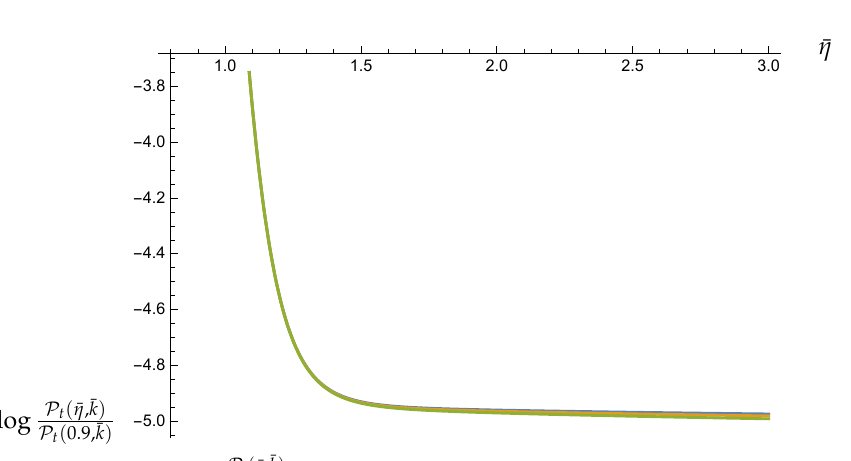
Figure A2. Plots of log P t ( ¯ η